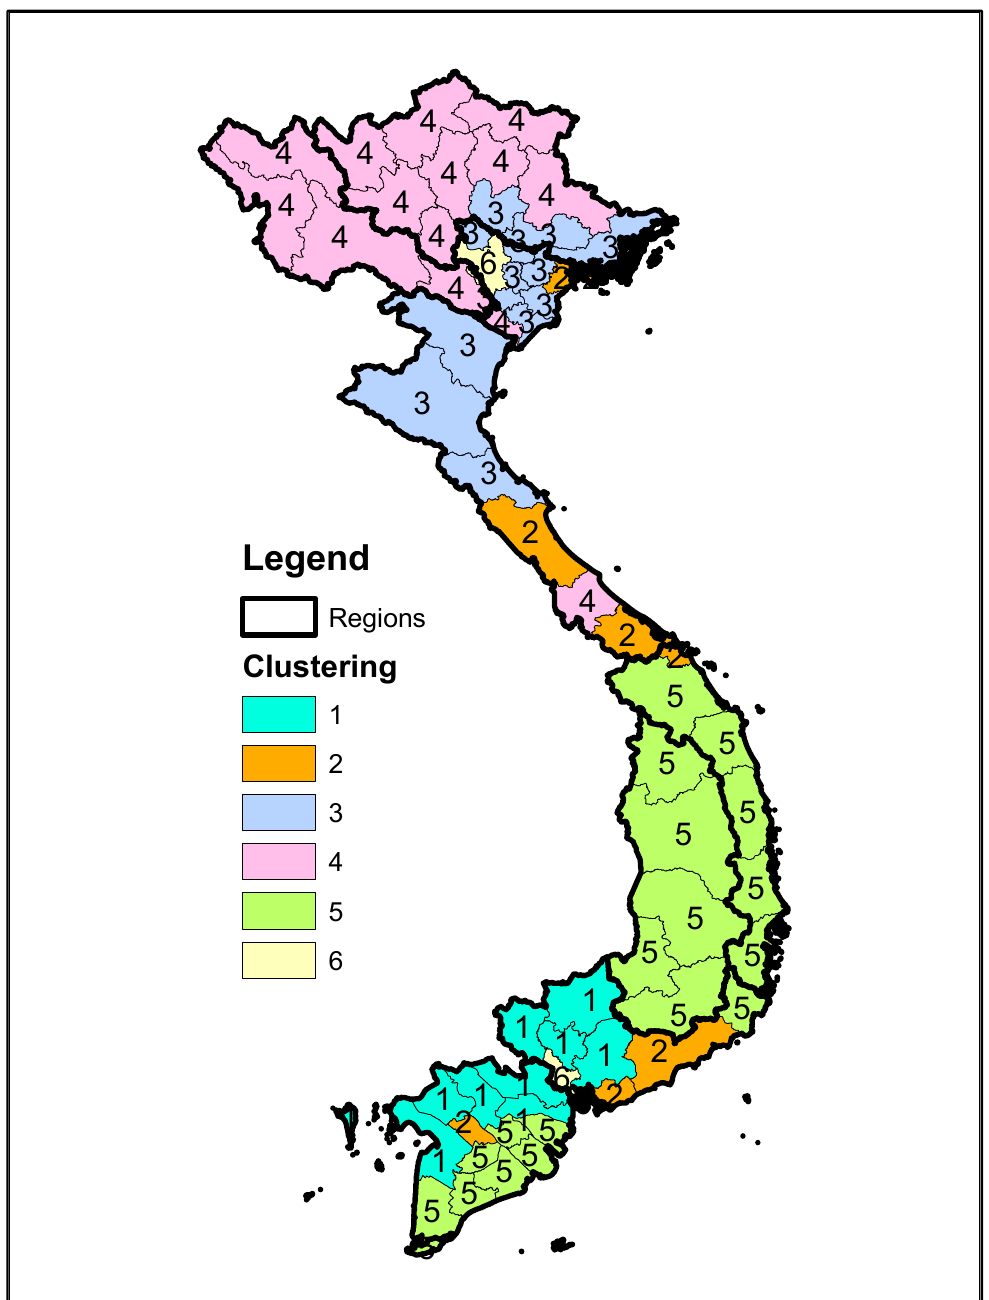
Figure A1 . The clustering distribution on map. Figure A1. The clustering distribution on